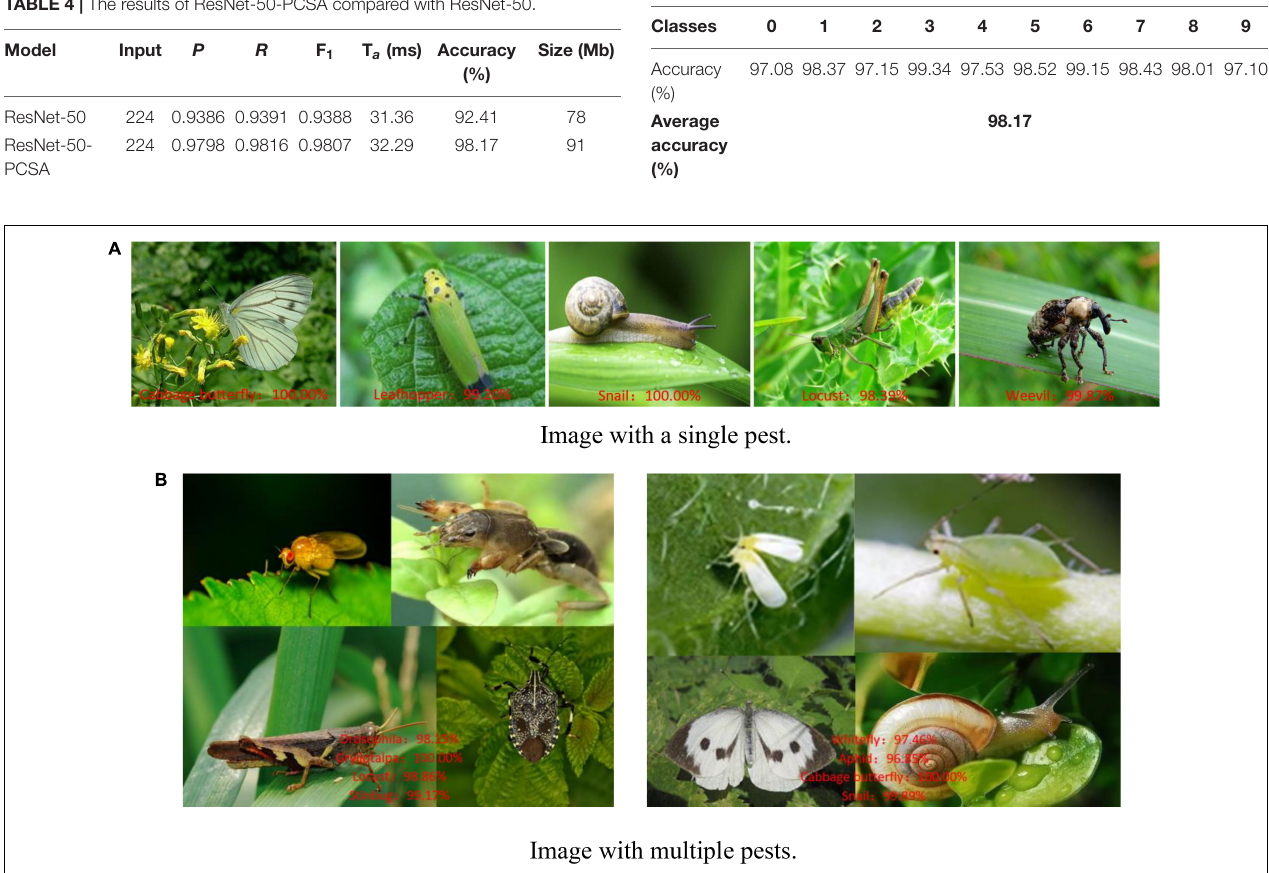
FIGURE 9 | Recognition results for crop pests. (A) Image with a single pest. (B) Image with multiple pests.